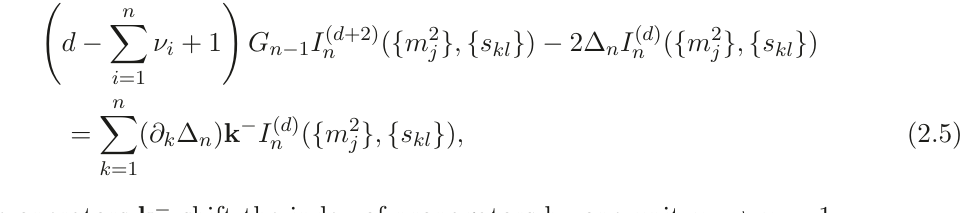
m 2 , s kl ) were given in refs. [6, j } { { }